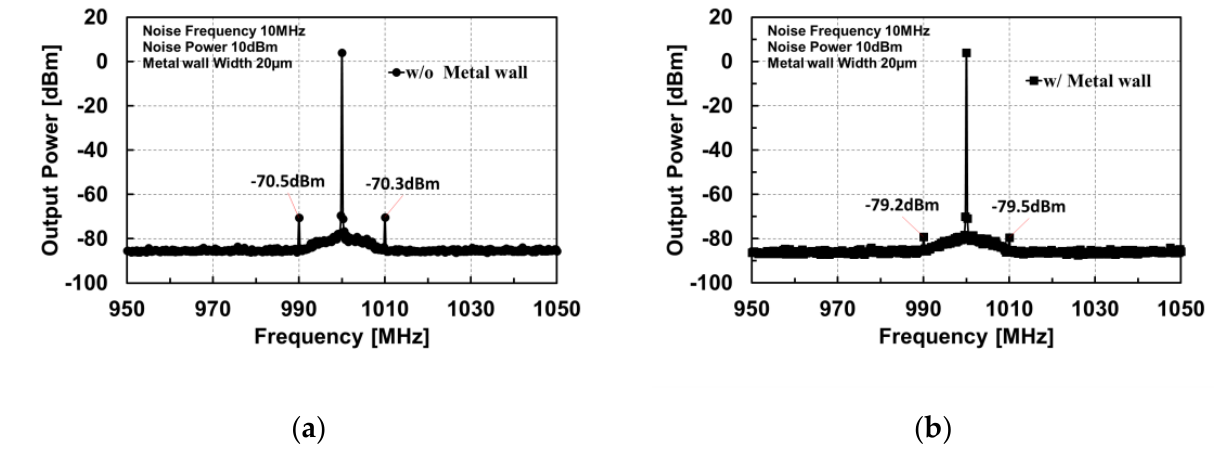
Figure 13. Measured output of the amplifier circuits: ( a ) without noise isolation, and ( b ) with metal wall isolation [34].